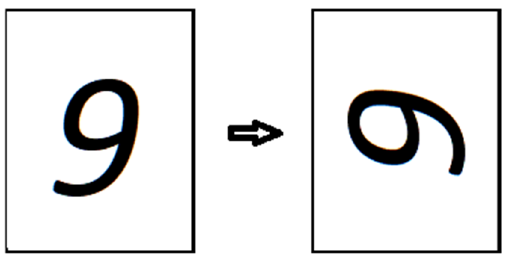
Figure 2. The first panel is a drawing of the digit nine (9), while the next panel is the same digit transformed by rotation [3].